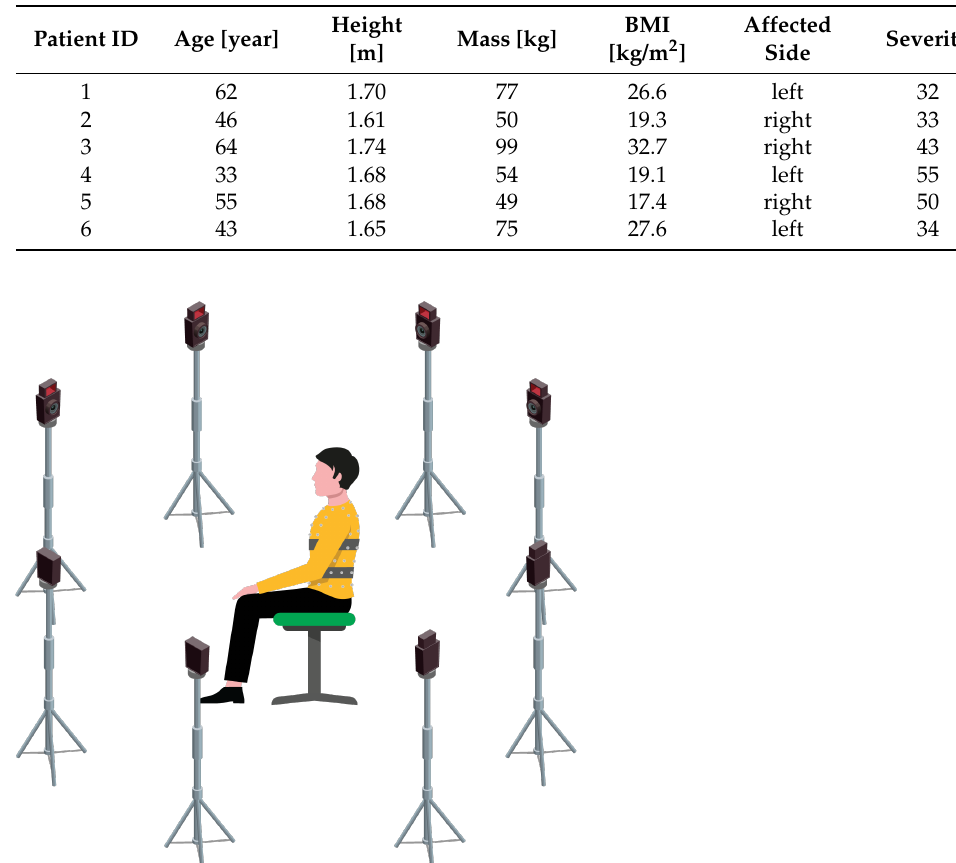
Table 1. Patient’s anthropometric measurements, affected side, and plegia severity.